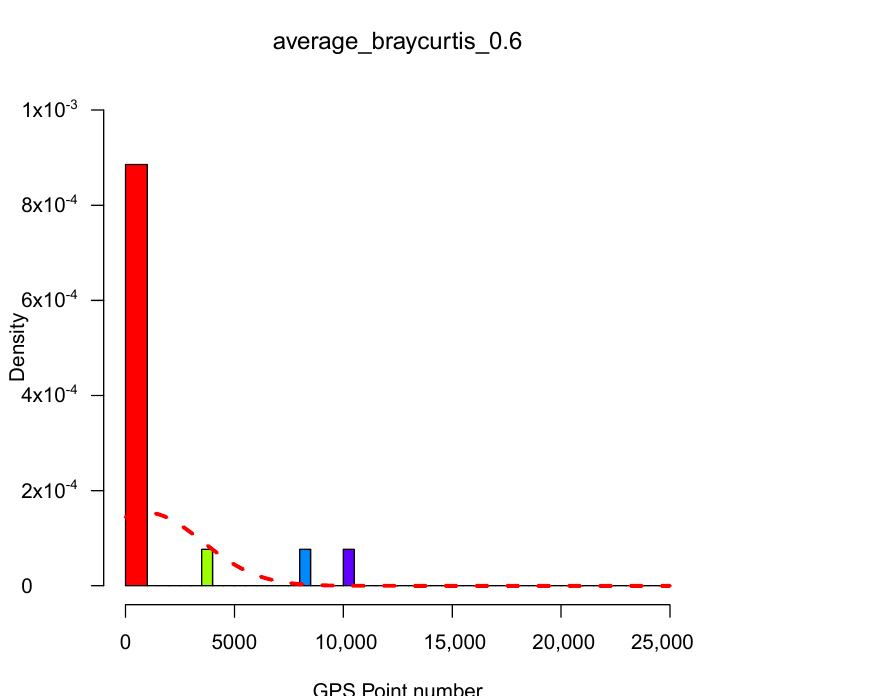
Figure 9. Density histogram for combination Average-BrayCurtis-0.6. This histogram shows a high density of clusters containing fewer than 5000 GPS points, which indicates an asymmetric distribution of the GPS points between generated